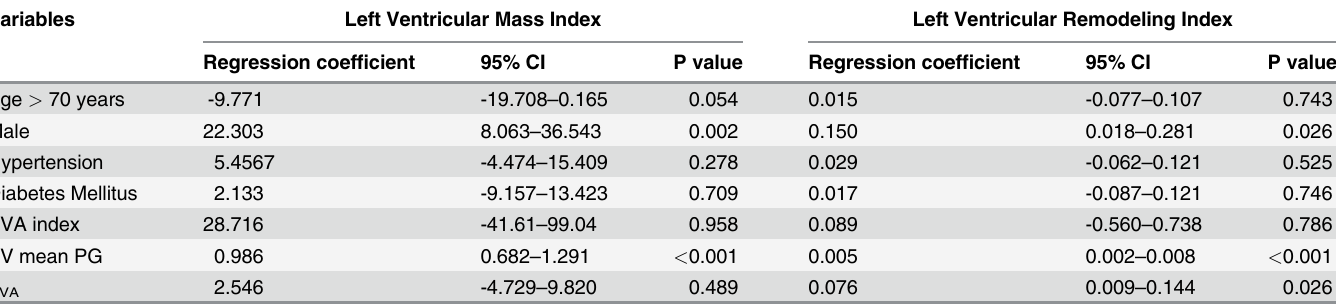
Table 5. Determinants of left ventricular mass index or left ventricular remodeling index. †